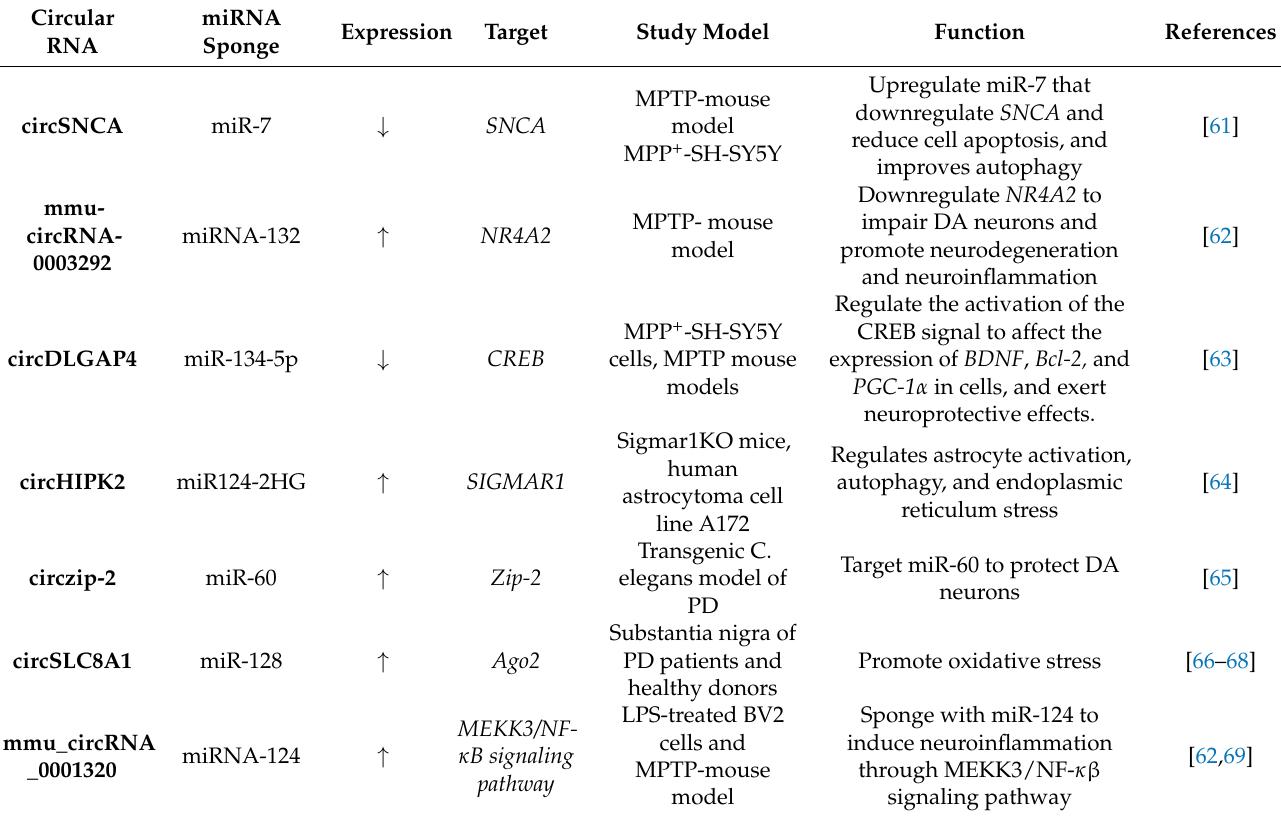
Table 2. CircRNAs involved in the neuroinflammation in PD. ↑ shows up-regulated, ↓ shows down-regulated. Circular